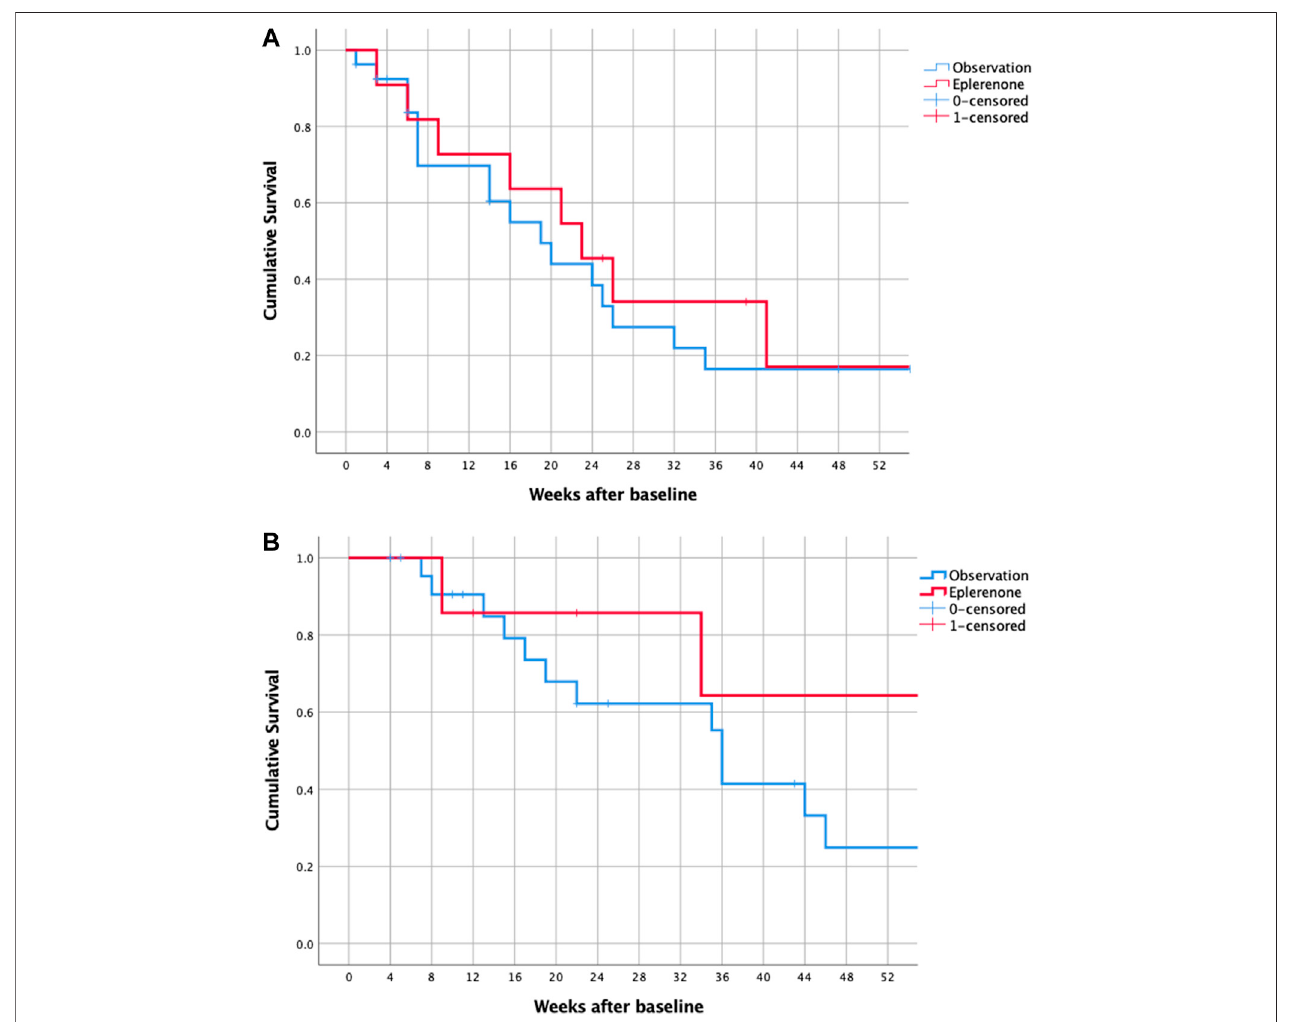
FIGURE 2 | Kaplan-Meier survival of all eyes with acute (A) and chronic (B) CSCR reaching complete resolution of SRF (event (cid:1) zero SRF). CSCR — central serous chorioretinopathy, SRF – subretinal fl uid.